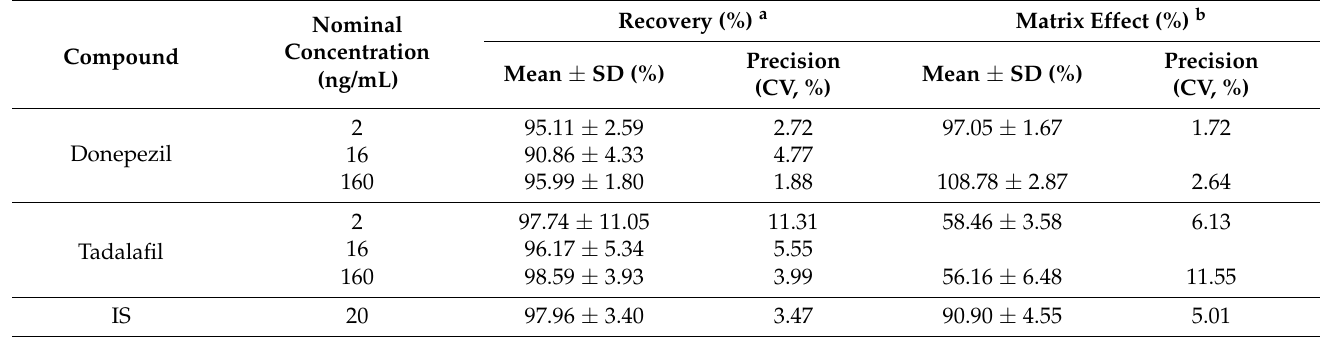
Table 3. Extraction recovery and matrix factor for donepezil, tadalafil, and lansoprazole (IS) from rat